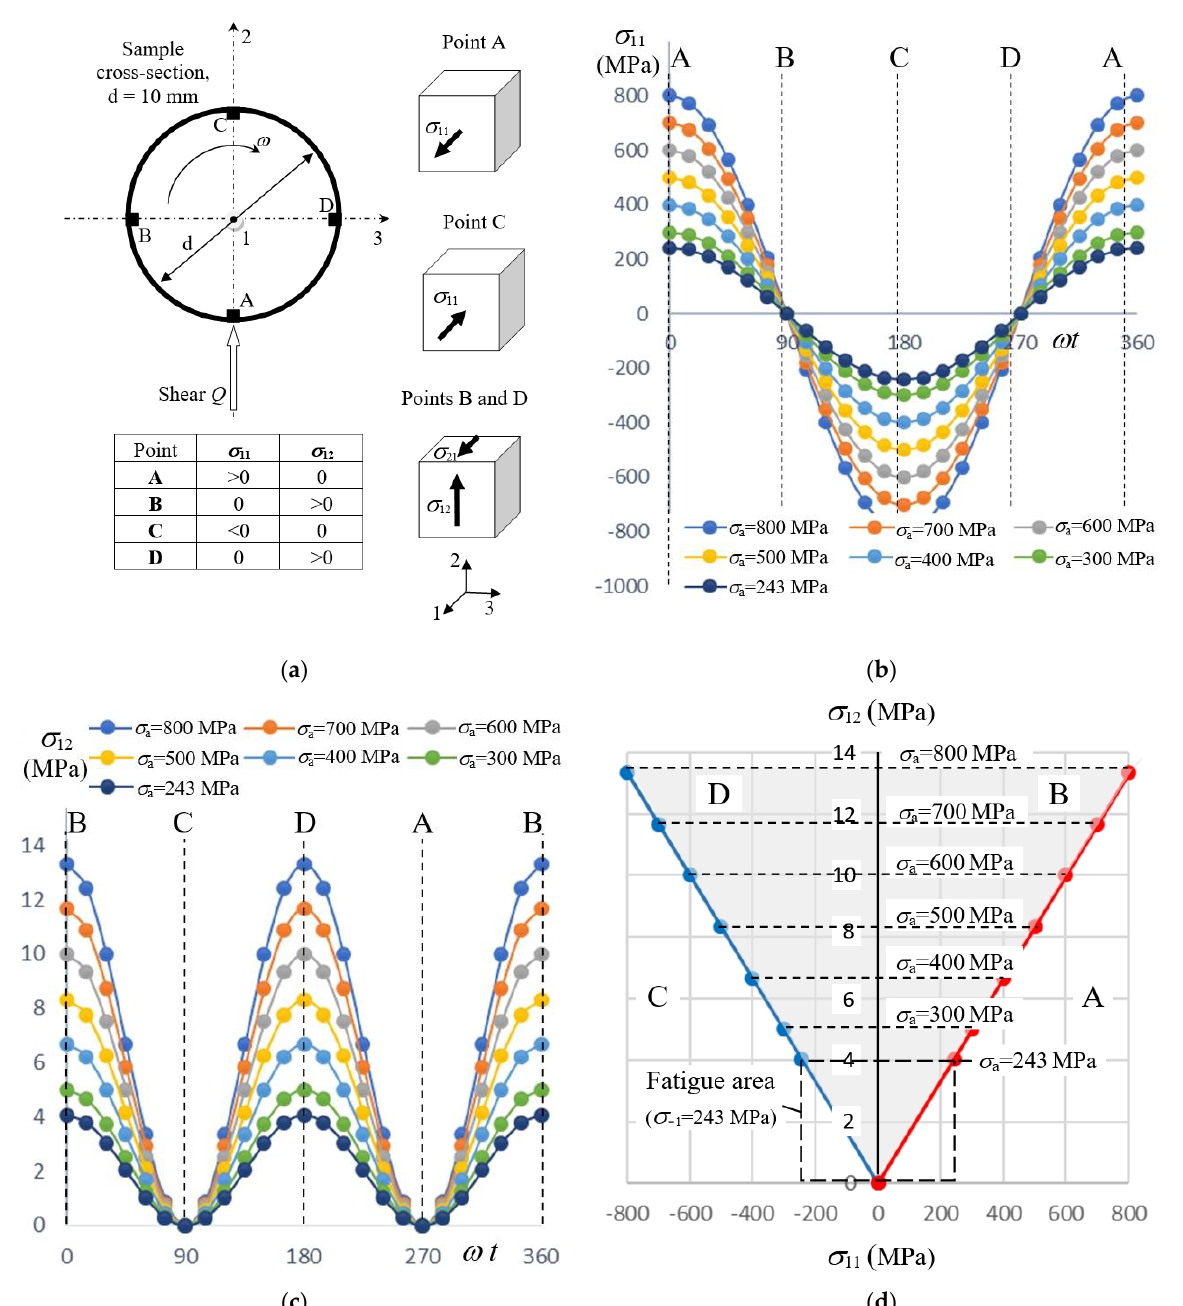
Figure 3. Theoretical representation of angle of revolutions ω t versus normal stress σ 11 and shear stress σ 12 : ( a ) points A, B, C, D are presented at different locations as small volumetric elements where normal stresses σ 11 and σ 12 reach their extreme values, ( b , c ) points A, B, C, D are presented at different locations as small volumetric elements where stresses σ 11 and σ 12 reach their extreme values, ( d ) graphical dependencies of stresses σ 11 and σ 12 , respectively, versus ω t for varying stress amplitudes σ a d, complex distribution of stresses σ 11 and σ 12 according to their location and stress amplitude σ a